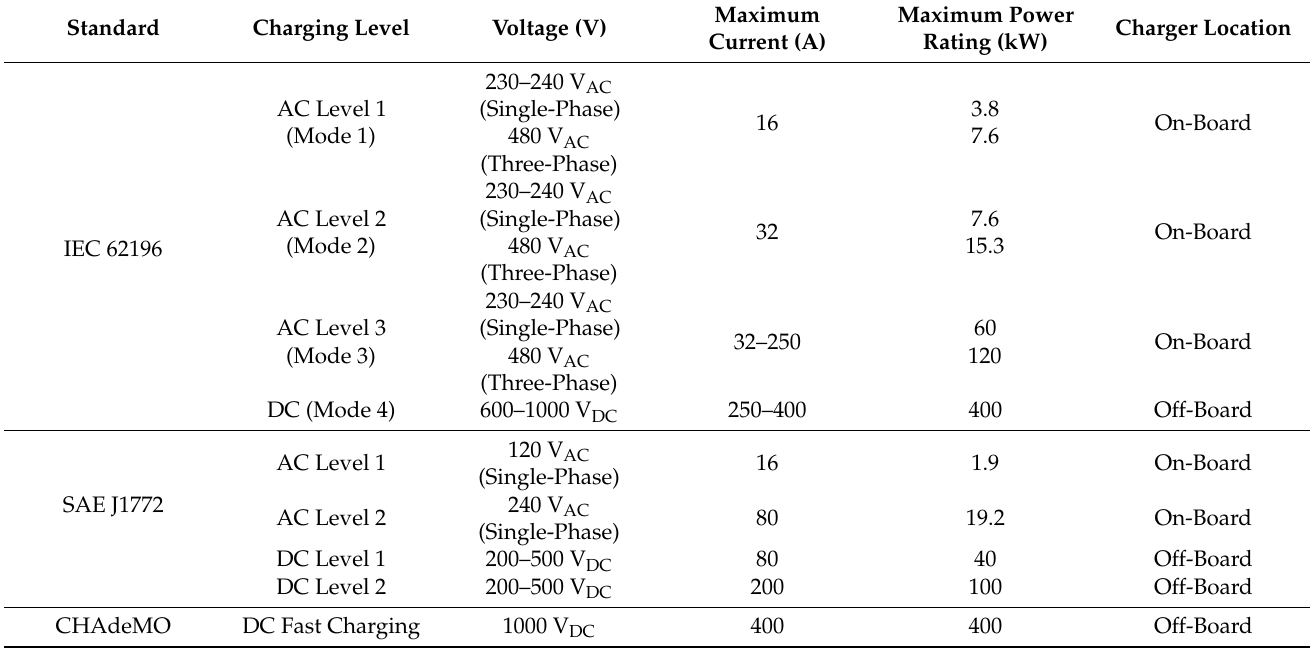
Table 1. Charge ratings of IEC 62196, SAE J1772 and CHAdeMO standards